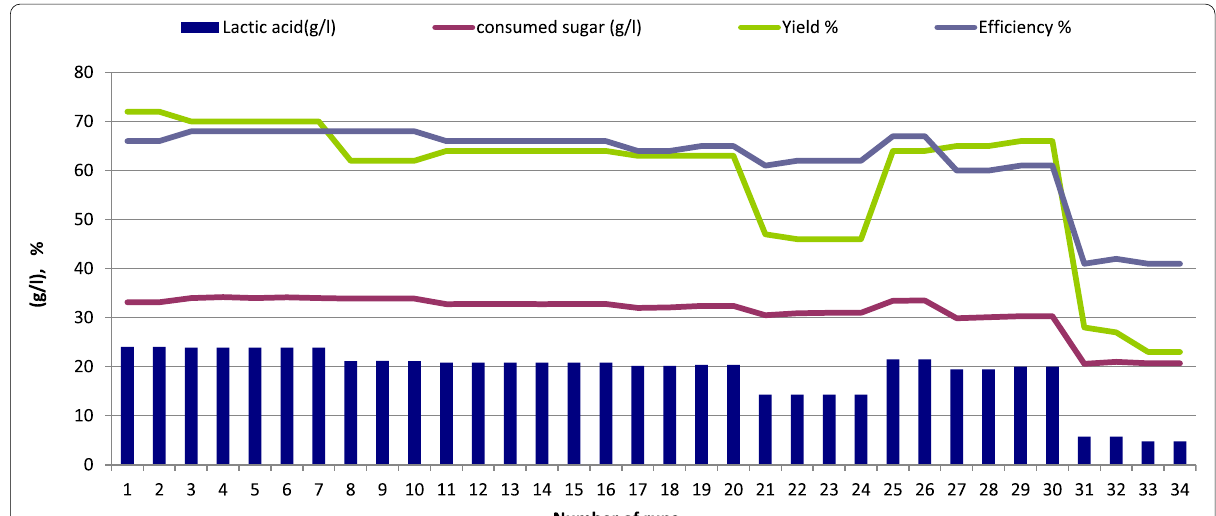
Fig. 7 Lactic acid production from salted cheese whey and whey permeate mixture (1:1, contained 10% sugar) using immobilized cells of Enterococcus hirae